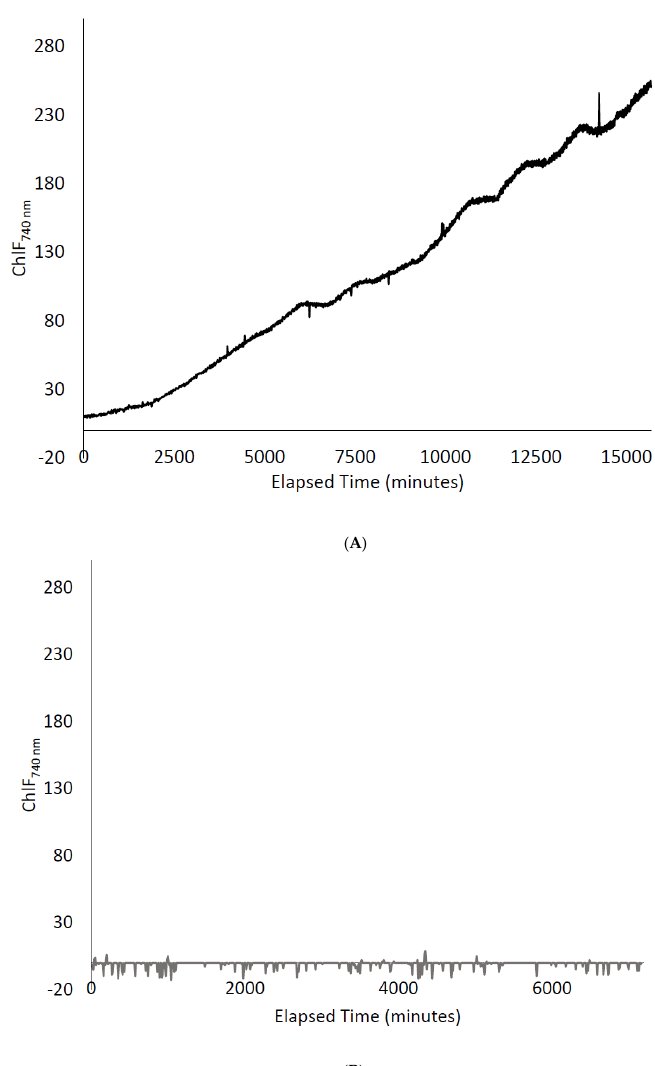
Figure A2. Chlorophyll fluorescence signal from growing lettuce plants ( A ) and from a black cloth control used to determine measurement noise ( B ). Both datasets are plotted on the same vertical scale to facilitate comparison of signal magnitude to noise